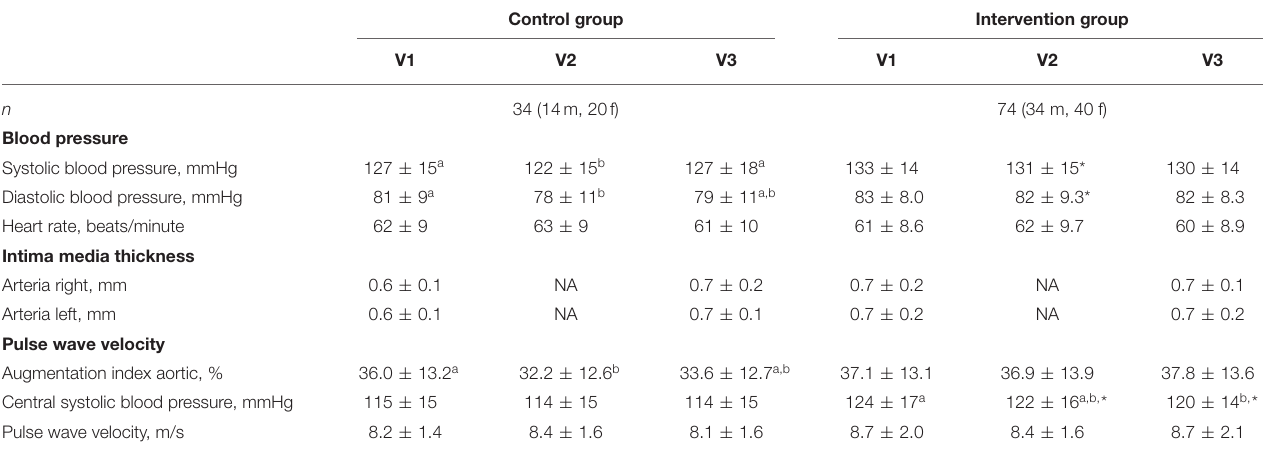
TABLE 4 | Changes of cardiovascular functions in the intervention vs. control group.